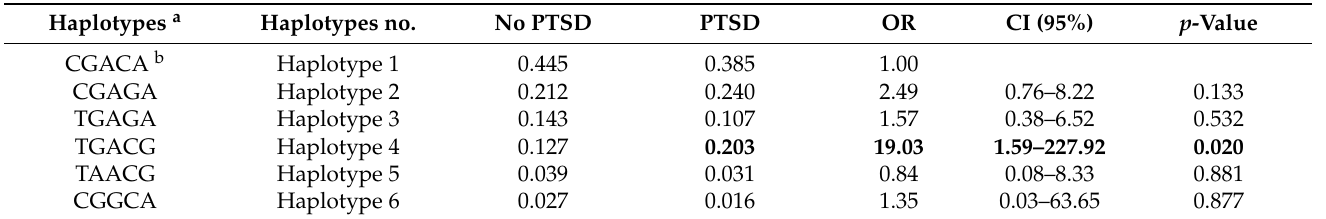
Table 3. GR gene haplotypes frequencies and association with lifetime PTSD in war